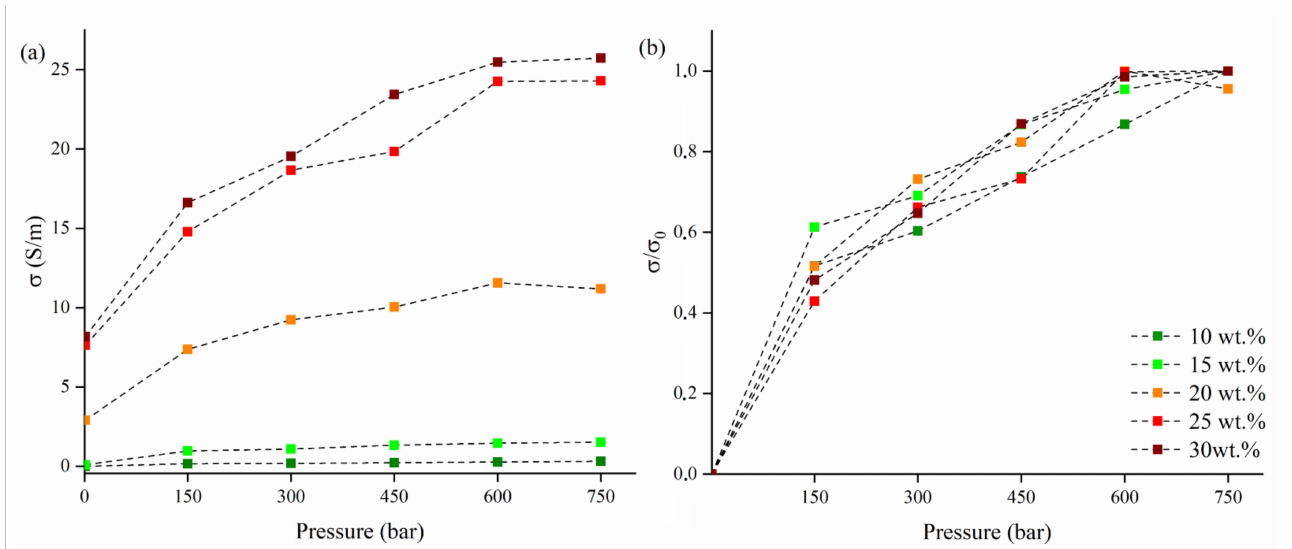
Figure 4. ( a ) Electrical conductivity measurement as a function of pressure WCB composites; ( b ) elec- trical conductivity normalized on the highest value measured across the pressure range